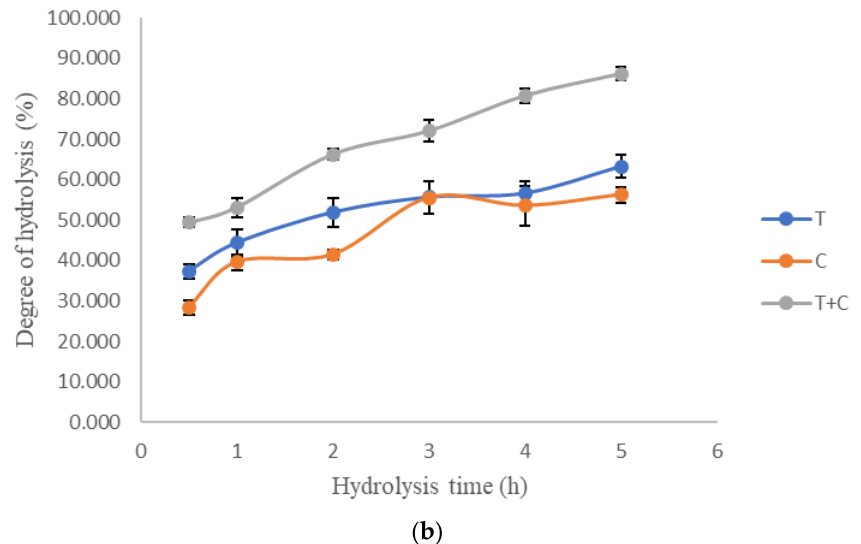
Figure 2. Effects of enzyme treatments (100% trypsin, T; 100% chymotrypsin, C and 50% trypsin + 50% chymotrypsin, T+C) on the degree of hydrolysis of egg white proteins at various ( a ) substrate-to-enzyme (S/E) ratio where the hydrolysis time is fixed at t = 3 h and ( b ) hydrolysis time where the S/E ratio is fixed at 30 ( w/w ). Results were reported as means with error bars representing the standard deviations of triplicate experiments.